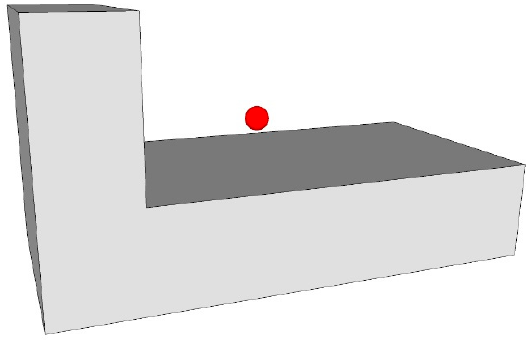
Figure 11. The node (red) placed out of the solid geometry due to variable ceiling height.